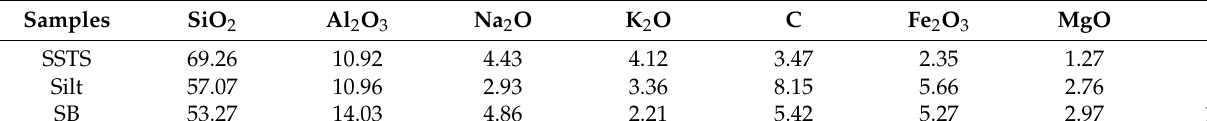
Table 2. Chemical components of SSTS, silt and SB.